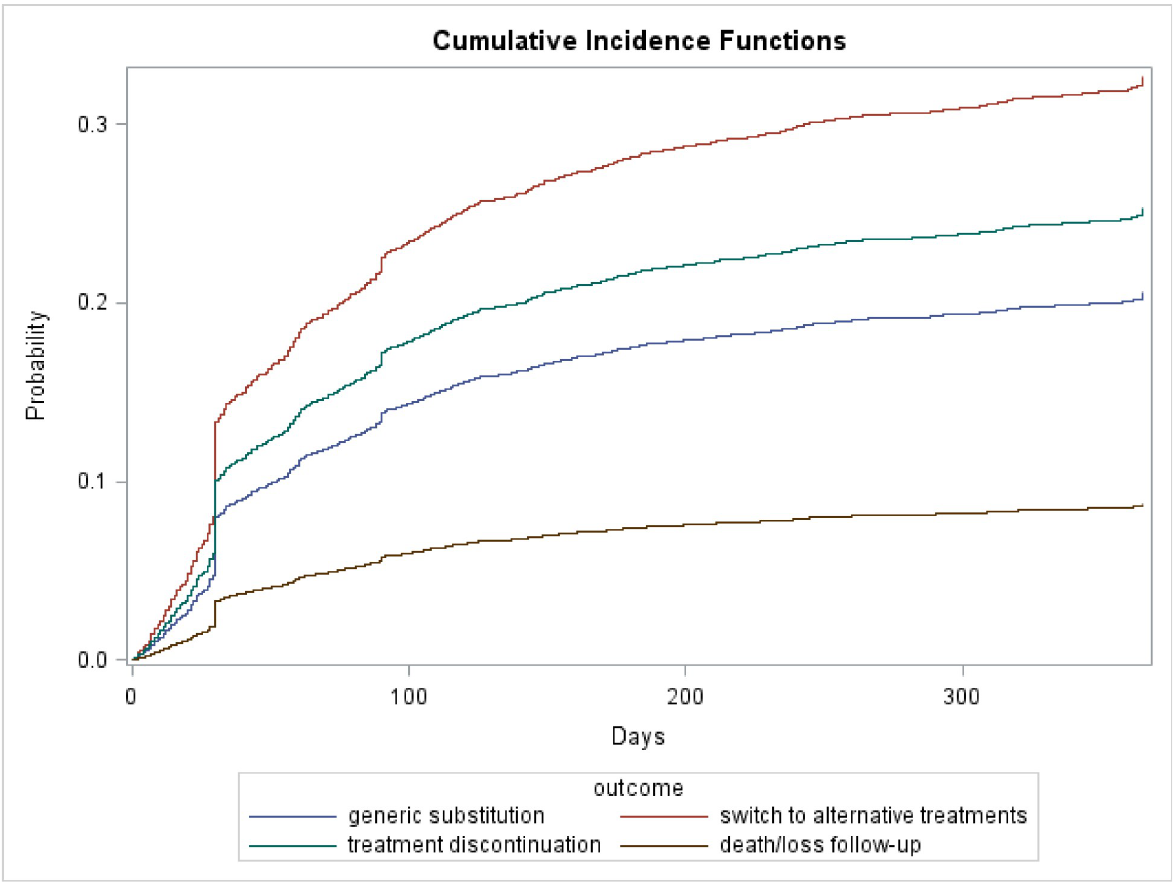
Fig 2. Cumulative incidence function plots for time to generic substitution and all competing risk outcomes within 12 months among Medicare beneficiaries who initiated brand escitalopram treatment (n = 1,464).